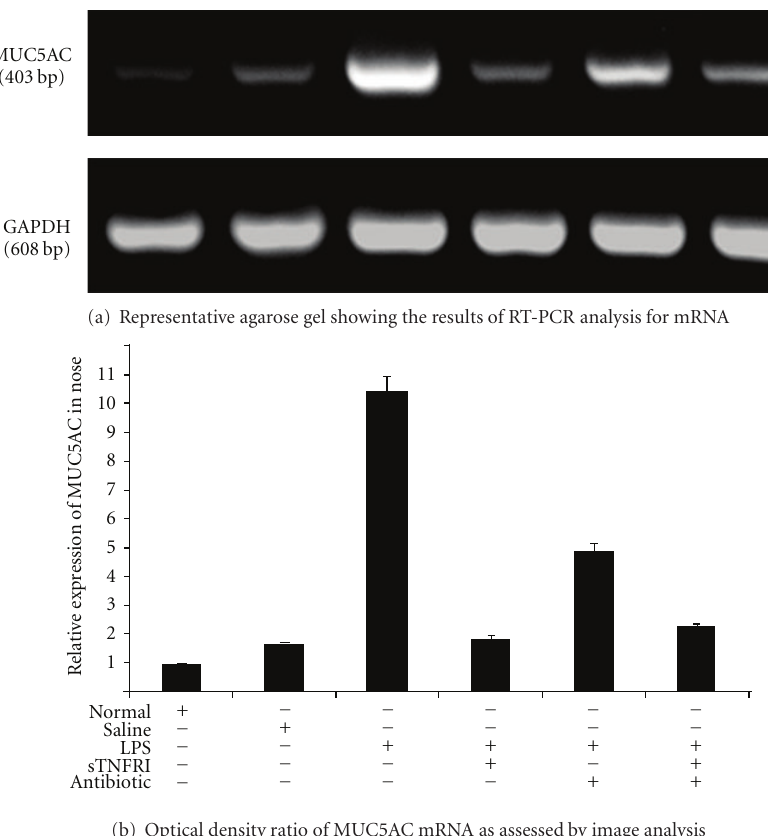
(b) Optical density ratio of MUC5AC mRNA as assessed by image analysis Figure 4: Expression of MUC5AC mRNA in the rat nose on the 1st day after the last instillation of LPS. Expression of MUC5AC mRNA increased significantly in rats treated with LPS, and the upregulation of MUC5AC mRNA expression was inhibited by sTNFRI, antibiotic, and sTNFRI/antibiotic ( P < .